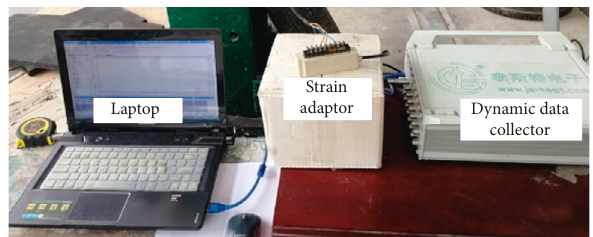
Figure 6: Dynamic data acquisition